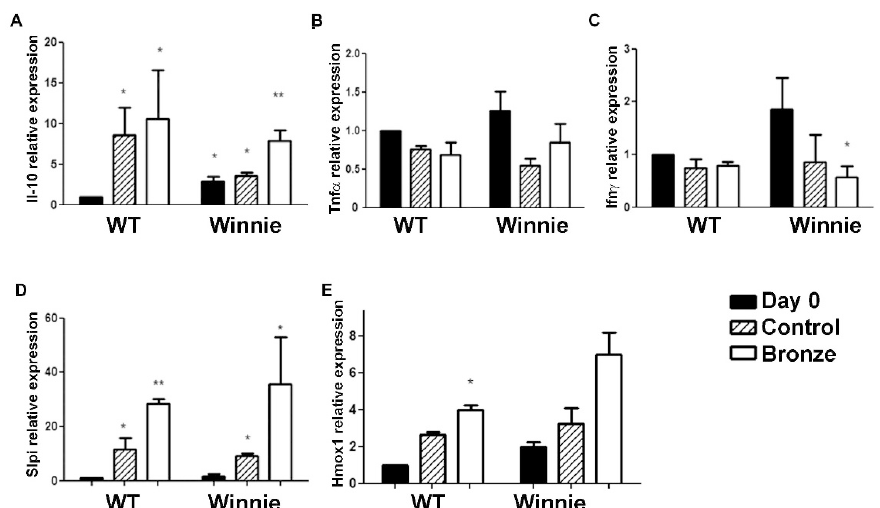
Figure 3. Two weeks of Bronze-enriched diet induced Slpi and Hmox1 expression in the medial colon of WT and Winnie mice. Histograms represent the average expression of Il-10, Tnf- α , Ifn γ , Slpi and Hmox1 ( A – E respectively) measured by real time PCR in the medial colon of WT and Winnie mice after two weeks of Control- (striped bars) and Bronze-enriched diet (white bars). Black bars represent the gene expression at Day 0. All bars represent mean expression ± SEM for each treatment. Control and Bronze dependent expression were compared to WT Day 0 for the statistical evaluation. Student’s t -test was used to compare every measurement to the corresponding WT Day 0 and evaluate the significance of the data. ** P < 0.01,* P < 0.05 (Student’s t -test). Grouped analyses were performed with the two-way ANOVA test, using Bonferroni as a post test.